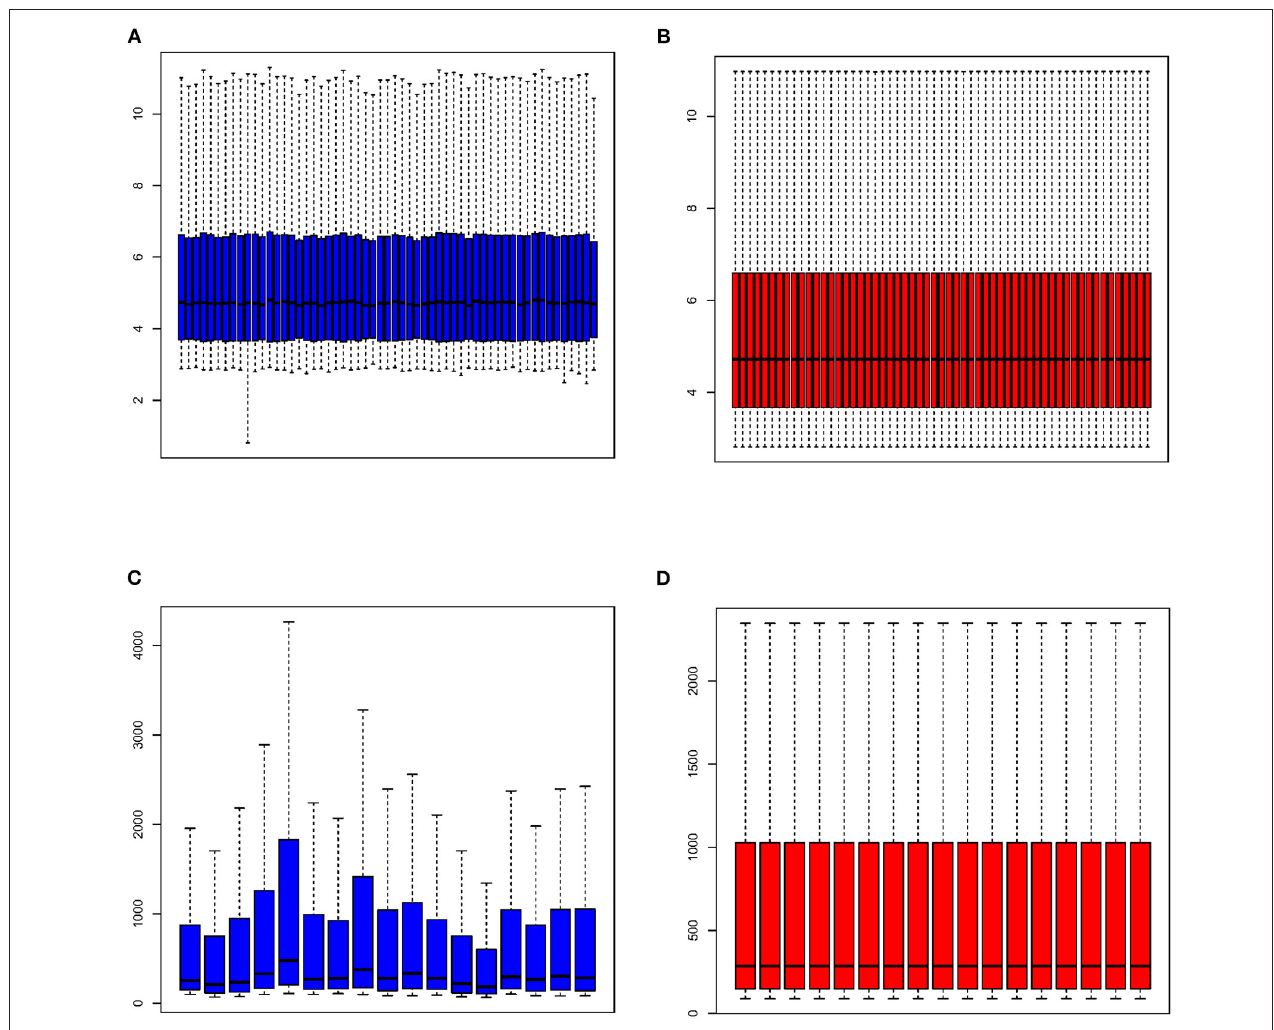
FIGURE 1 | The box diagram of expression profile before and after normalization. GSE117261 expression profile before (A) and after (B) normalization; GSE48149 expression profile before (C) and after (D)